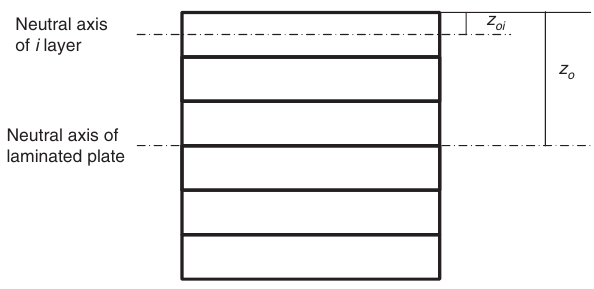
Figure 9 Schematic of the six-layer composite with neutral